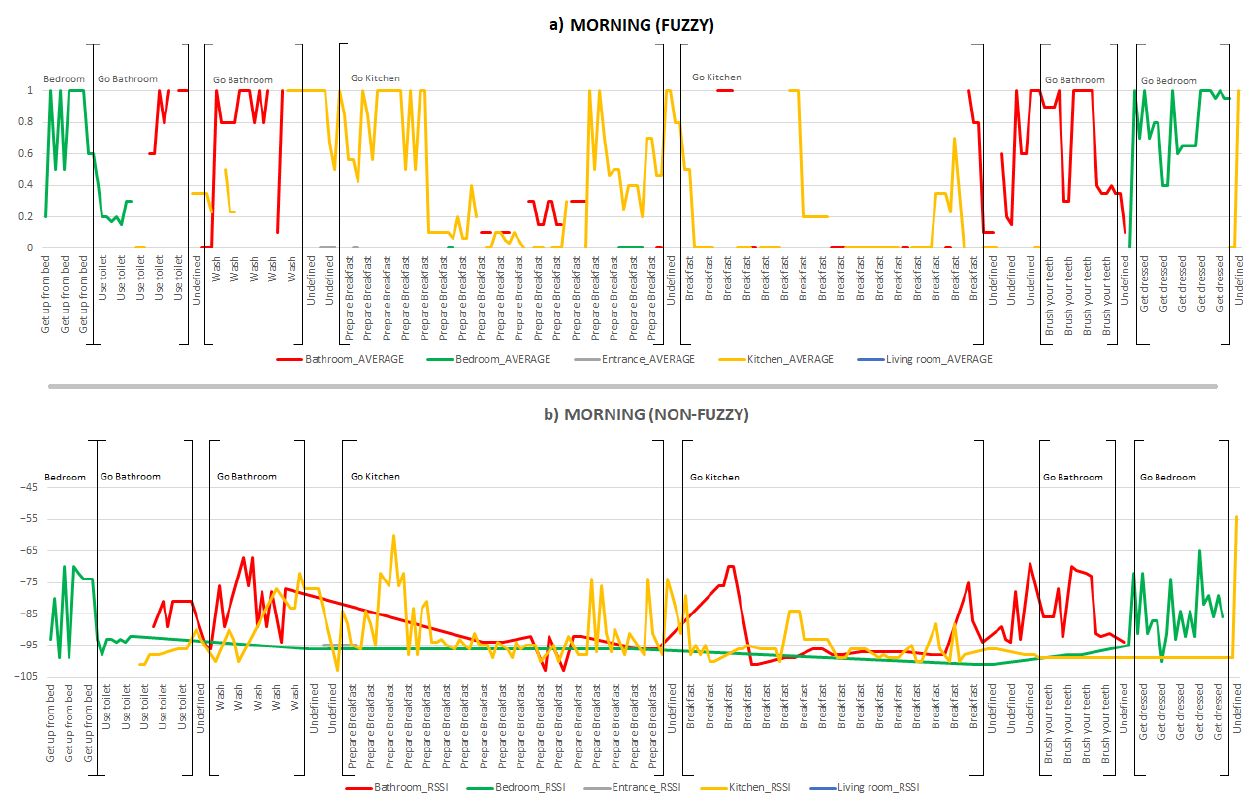
Figure 5. Areas visited and activities carried out by the inhabitant in the morning ( a ) with fuzzy processing and ( b ) non-fuzzy (raw